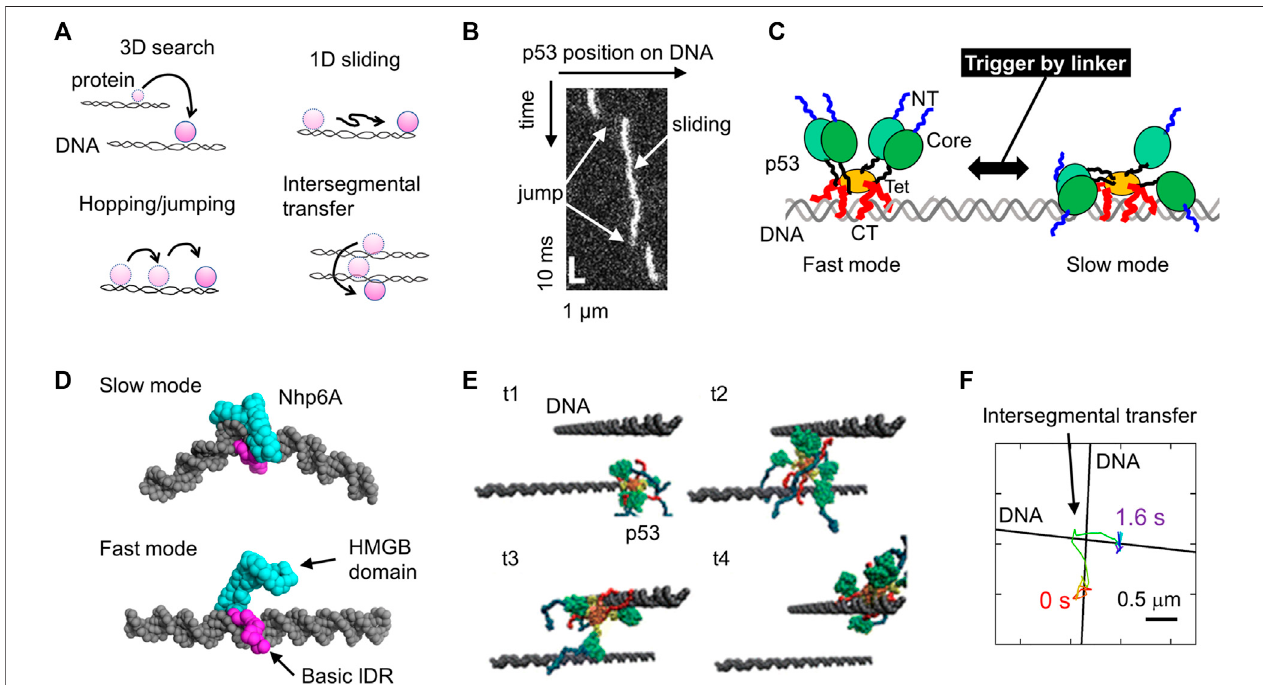
FIGURE 1 | Molecular actions of DNA-binding proteins on DNA. (A) Four target search mechanisms of DNA-binding proteins, including 3D search in solution, 1D sliding along DNA, hopping and jumping along DNA, and intersegmental transfer. (B) Sliding and jumping of p53 along DNA as monitored using SM fl uorescence microscopy. (C) Schematicdiagramofthetwoslidingmodesofp53identi fi edusingSM fl uorescencemicroscopy.p53iscomposedoftheNT(blue),Core(green),linker (black),Tet(orange),andCT(red)domains.NTandCTrepresenttheN-terminalandC-terminal,respectively.Thelinkertriggerstheswitchbetweenthetwomodes. (D) Representativestructuresoftwomodes ofNhp6A asidenti fi edincoarse-grainedMDsimulations. (E) Intersegmental transfertrajectoryofp53 incoarse-grainedMD simulations.Thetime elapsedfromt1tot4. (F) Intersegmental transfertrajectoryofp53asobservedviaSM fl uorescencemicroscopy. Ap53moleculetransferred atthe intersectionbetweentwoDNAmolecules.Panels(A-D,F)areadaptedfromvariousreferences(Itohetal.,2018;Subektietal.,2020;Kamagataetal.,2021b;Kamagata, 2021)withsome modi fi cations. Panel (E) wasreprinted withpermissionfrom (Takada et al.,2015) Copyright 2015AmericanChemical Society withsome modi fi